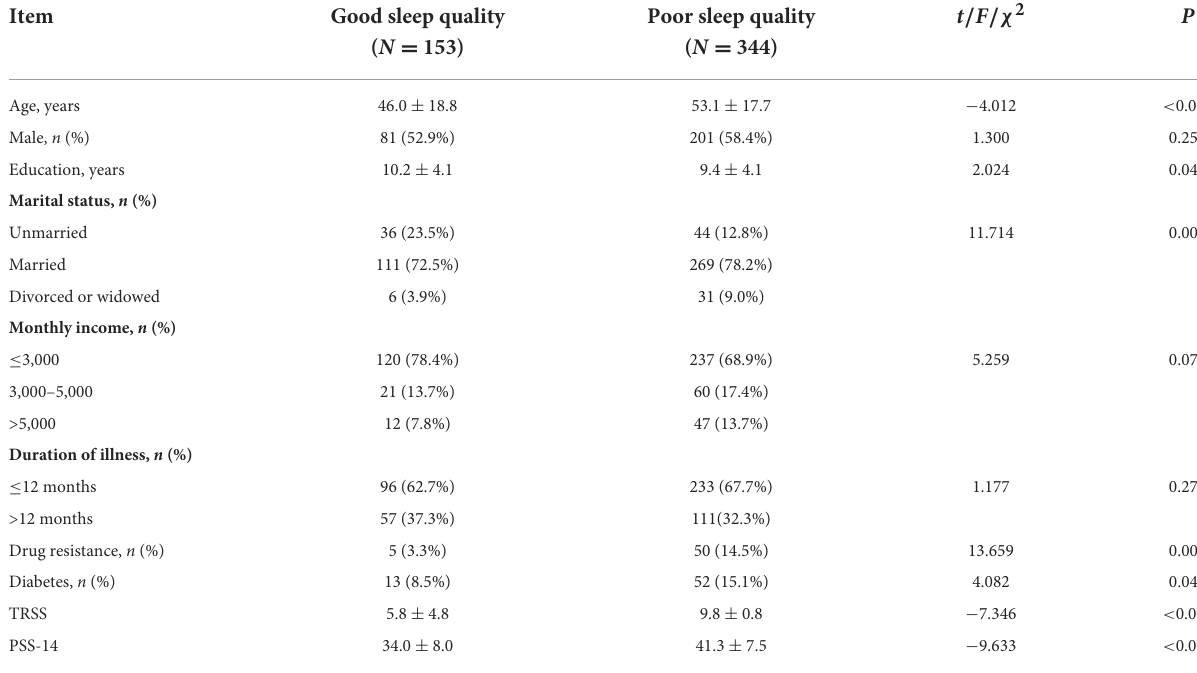
TABLE 2 Demographic characteristics, stigma and perceived stress in patients with